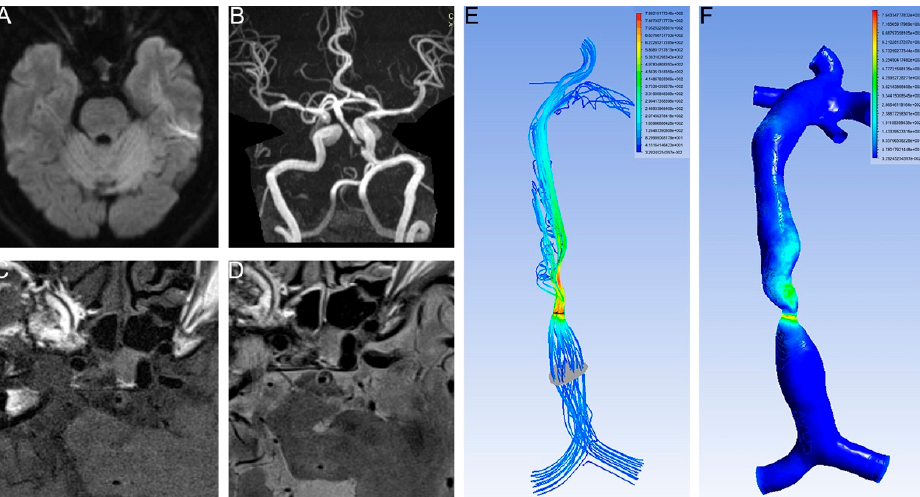
Figure 1. No infarction occurred in the lower proximal WSS. ( A ) DWI showed no infarction. ( B ) T2 images of HR MRI showed intact fibrous cap. ( C ) T1 images of HR MRI showed intact fibrous cap. ( D ) T2 images of HR MRI showed intact fibrous cap. ( E ) Velocity of BA. The planes (gray and dark) represent the place we measured. ( F ) WSS of BA. Proximal WSS was 2.88Pa and stenotic WSS was 490.78Pa.